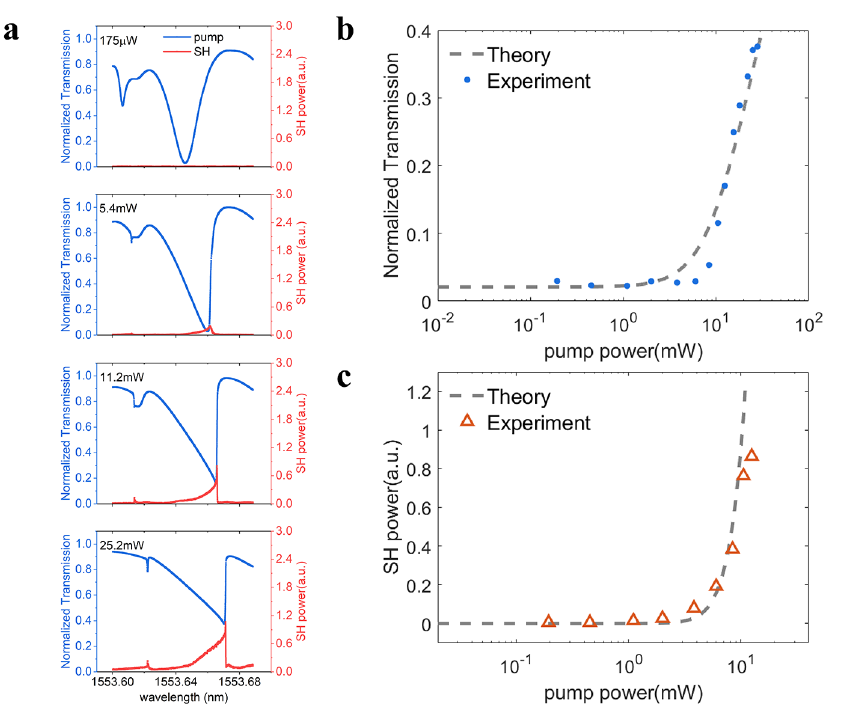
Fig. 2 Experimental observation of self-induced transparency in a one-port perfect absorber. ( a ) Experimentally measured transmission spectra of the input pump (blue) and its SHG (red) at various pump power. Self-induced transparency manifests itself at the higher pumping (bottom), in contrast to the perfect absorption state at the lower pumping (top). The corresponding transmission rate of the input pump ( b ) and the SHG power ( c ) are mea- sured with respect to the pump power, both exhibit quadratic dependences due to the second-order